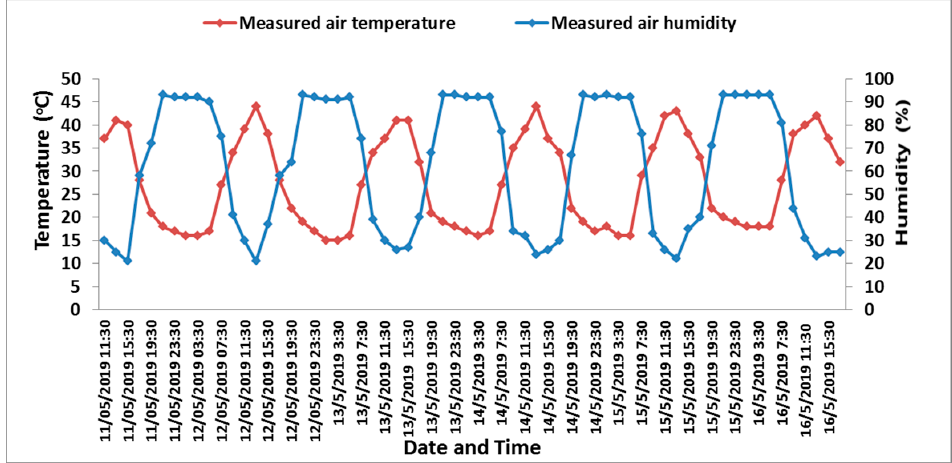
Figure 9. Air temperature (°C) and relative humidity (%) recorded by the designed automated monitoring system.